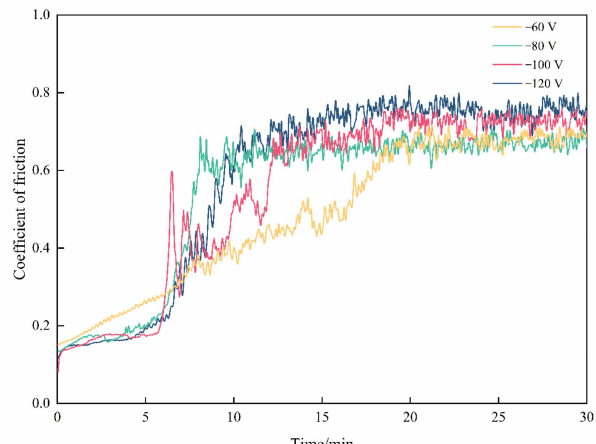
Figure 8. Friction coefficient curve of the